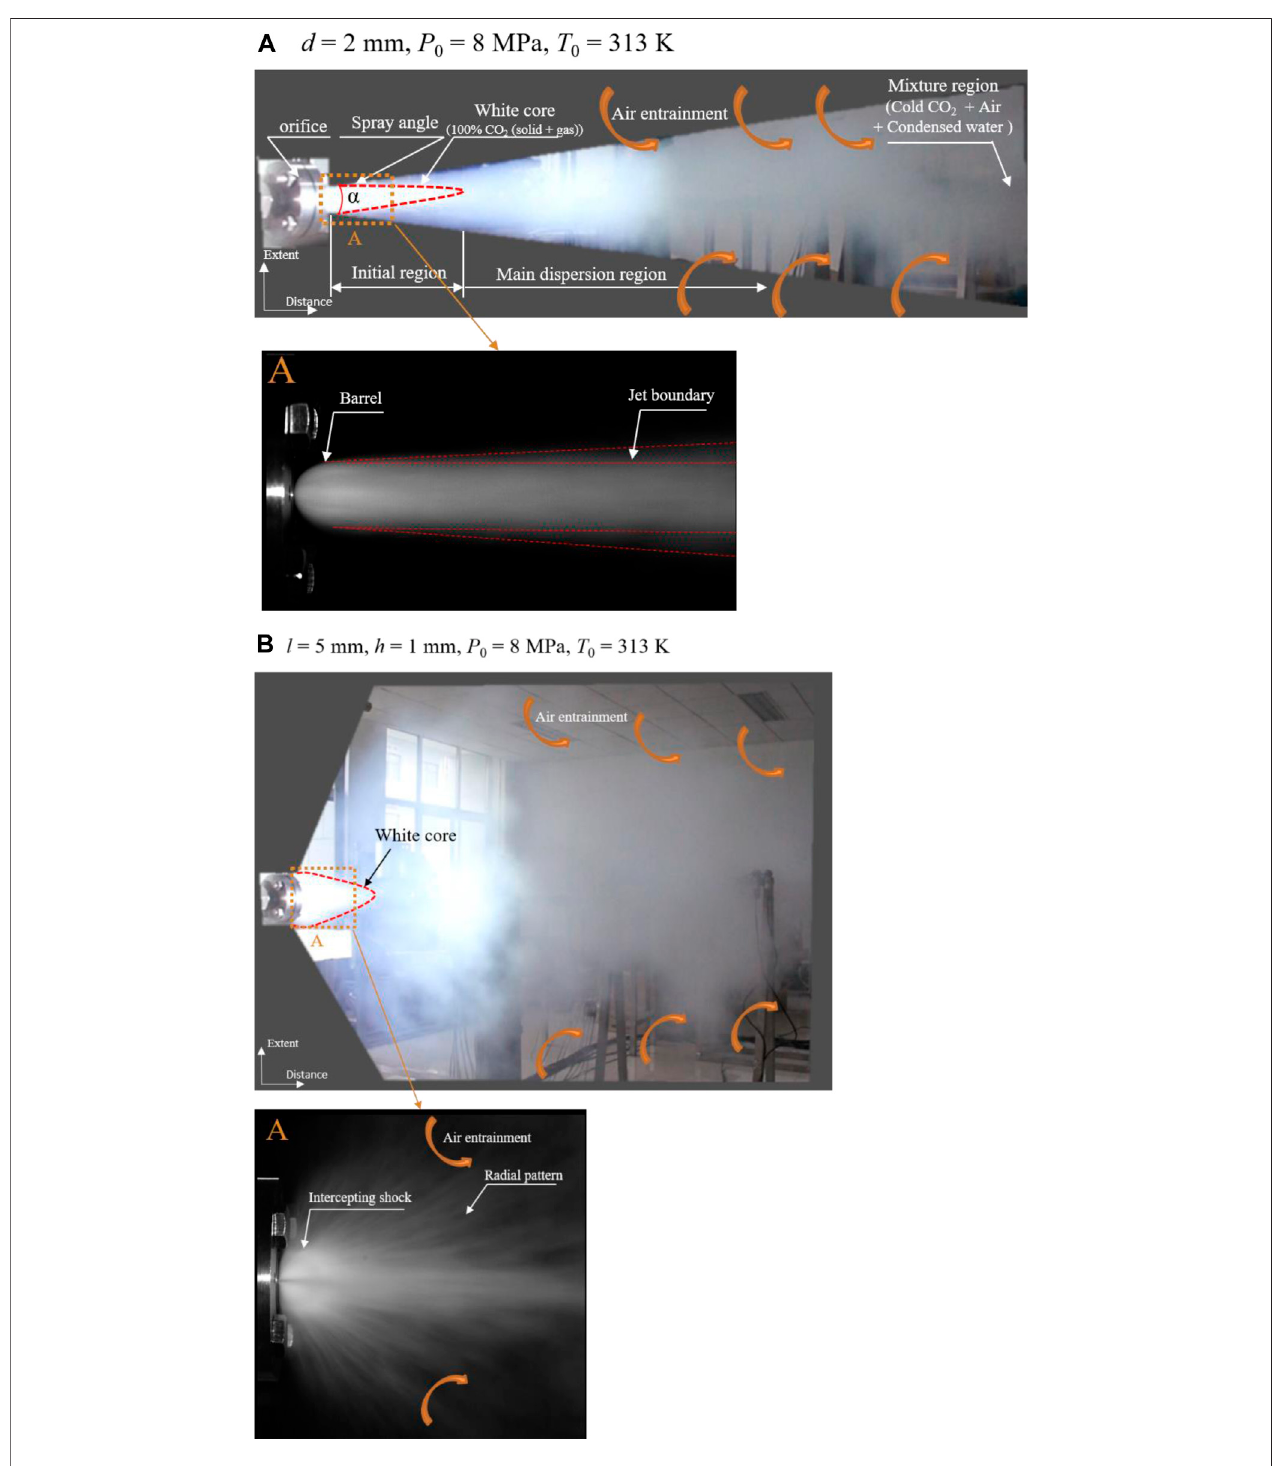
FIGURE 4 | The patterns of jet of supercritical CO 2 for circular (A) and rectangular (B) ori fi ces.